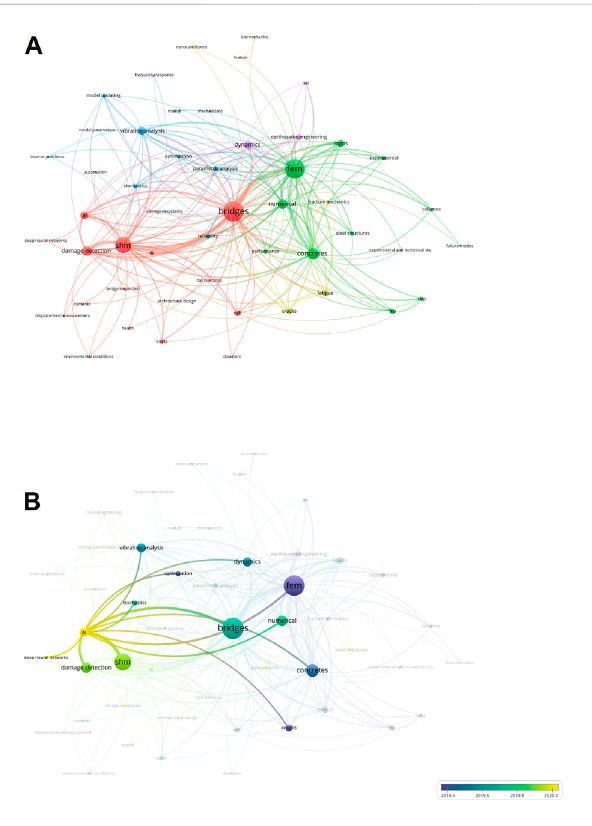
FIGURE 9 Co-occurrence relationships between keywords: (A) Keywords clusters and (B) AI